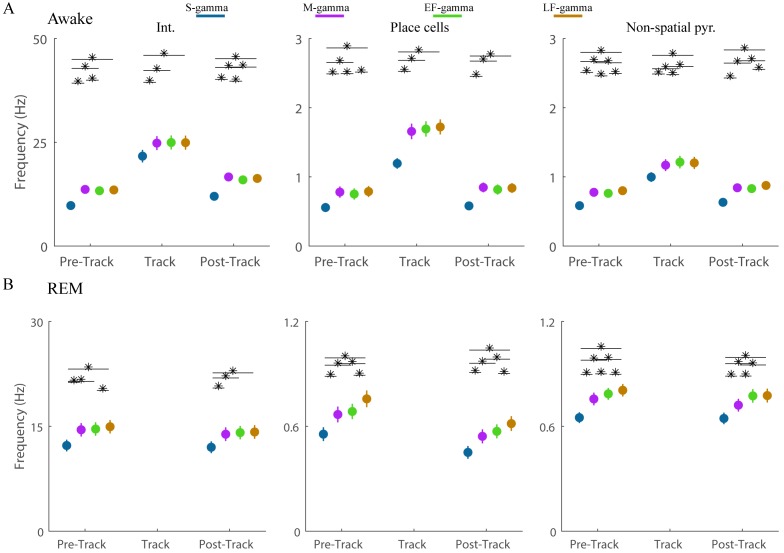
Firing rates of single units during the four TG states in awake periods.(A) Firing rate of interneurons (left panel, n = 128), place cells (middle panel, n = 142), and non-spatial pyramidal cells (right panel, n = 420) are shown. * denotes significant differences, paired t test, FDR correction for the 18 = 6 (states pairs) × 3 (experiment sessions) comparisons (q = 0.05). (B) As in (A) but during REM periods. * denotes significant difference, paired t test, FDR correction for the 12 = 6 (states pairs) × 2 (experiment sessions) comparisons (q = 0.05). Circles indicate mean, error bars indicate standard error of the mean.